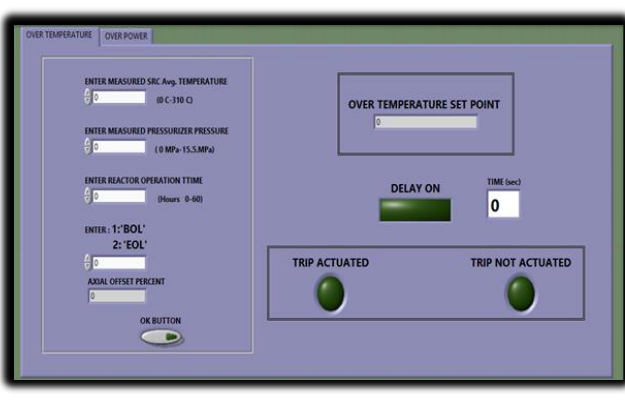
Fig. 11. ACP1000 over temperature parameter display system in LabVIEW